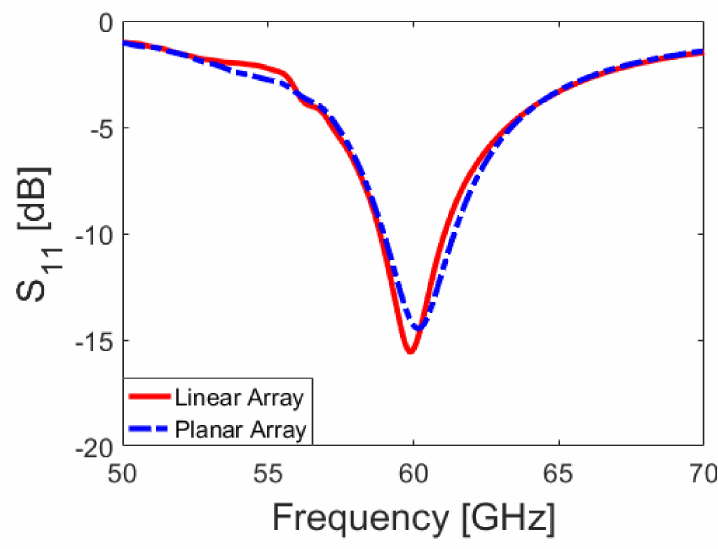
Figure 6. Showing the S 11 results of the linear and planar